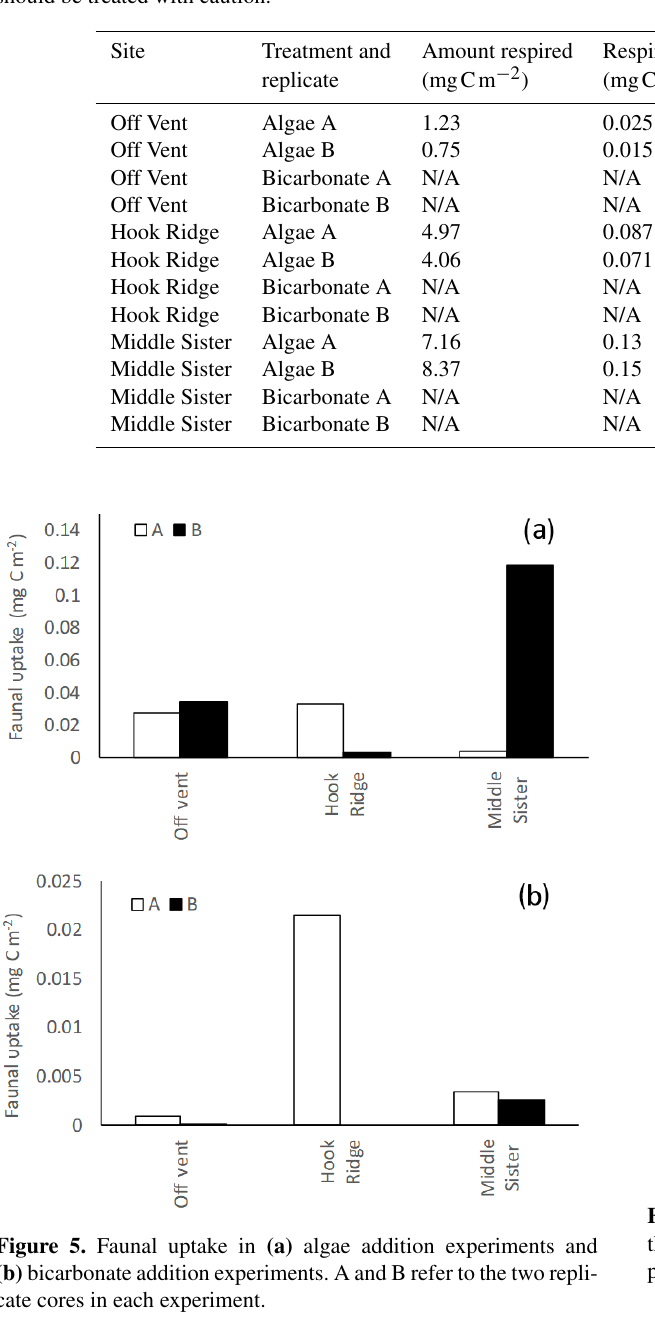
Table 2. Amount of C in pools at the end of the experiment, and respiration rates (algae addition experiments only). N/A indicates that it was not appropriate to measure respiration in bicarbonate addition experiments, n.d. indicates no data due to missing sample, and “low” indicates an unmeasurably low value. The value marked * indicates detectable bacterial 13 C uptake, but very close to detection limits – thus, the value should be treated with caution.